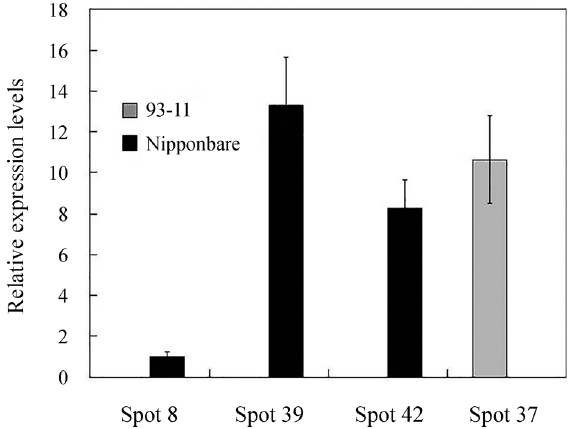
Figure 5 - Relative expression levels of 2,3-bisphosphoglycerate- independent phosphoglycerate mutase, L-ascorbate peroxidase 1, chloro- phyll A-B binding protein and harpin binding protein 1 in 93-11 and Nipponbare. The X-axis shows the protein spot number and the Y-axis shows the relative expression level of each protein.